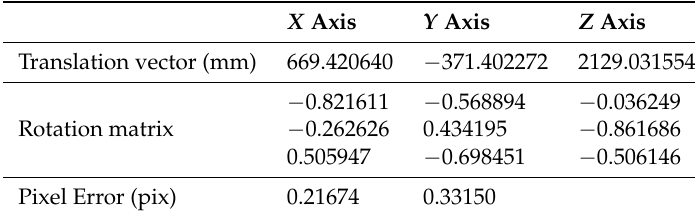
Table 3. Extrinsic parameters of the right camera.